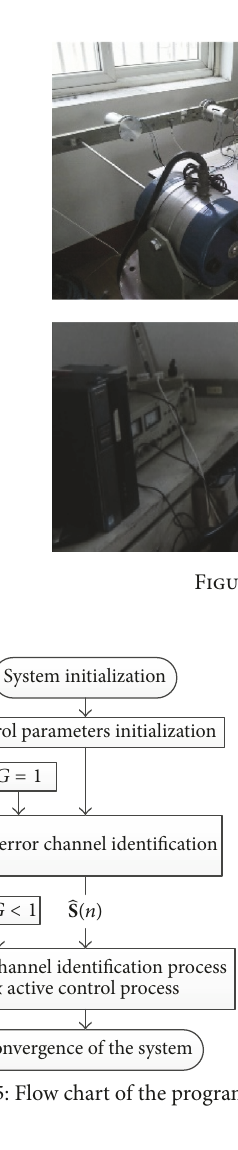
Figure 13: The schematic diagram of active vibration control system.